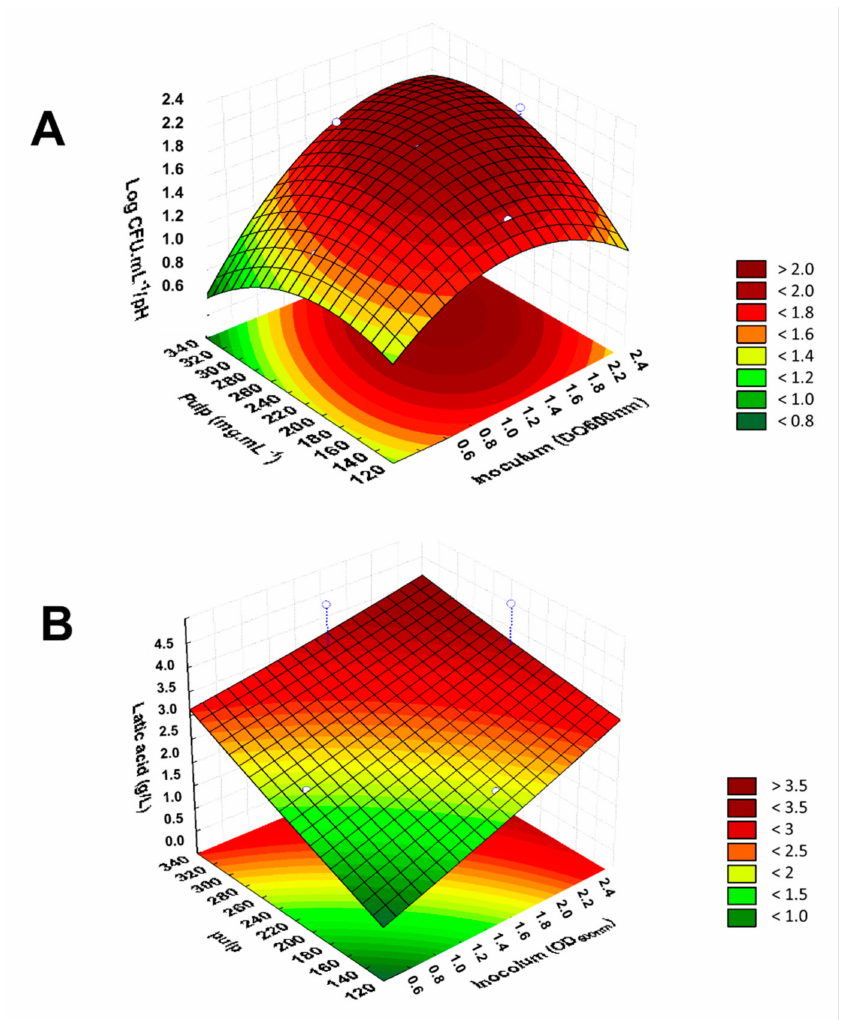
Figure 2. Effects of inoculum density and pulp concentration on the growth and production of organic acids by L. rhamnosus ATCC 9595 in Platonia insignis juice. ( A ) Response surface obtained for the Bacterial growth/pH ratio as a function of the studied variables. ( B ) Response surface obtained for the production of lactic acid as a function of the variables